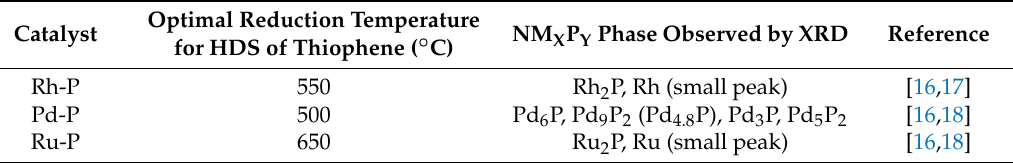
Table 6. Optimal reduction temperature for NM-P catalysts and NM X P Y phase observed by XRD after